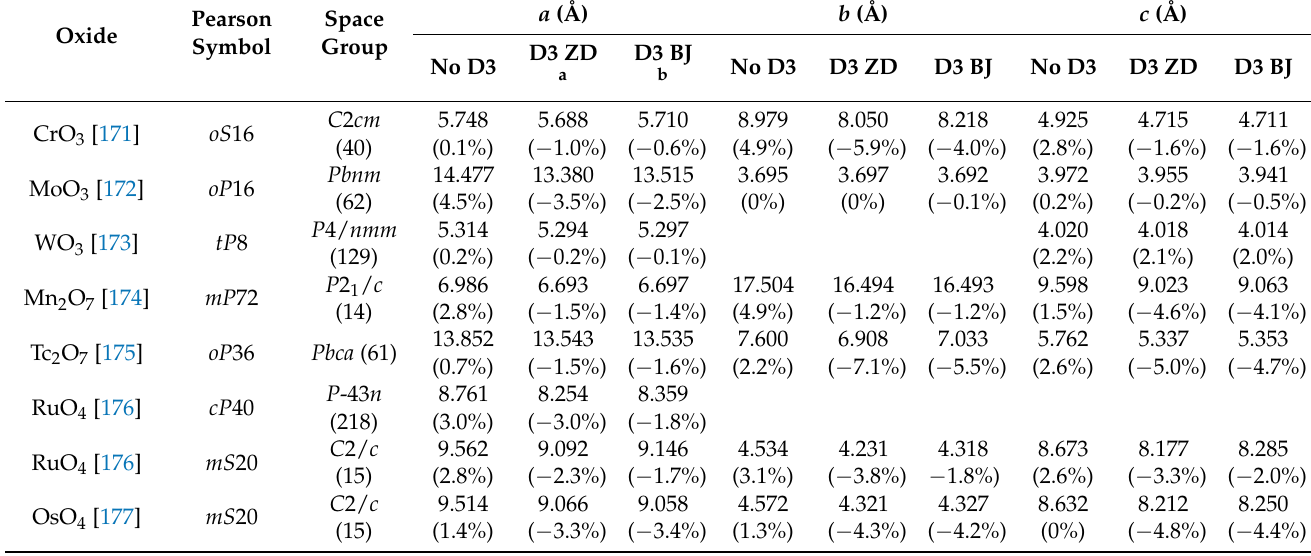
Table 2. Optimized lattice parameters of binary d -metal oxides with molecular crystal structures, obtained at the DFT-PBE0/TZVP and DFT-PBE0-D3/TZVP levels of theory. Errors with respect to experimental lattice parameters are shown in